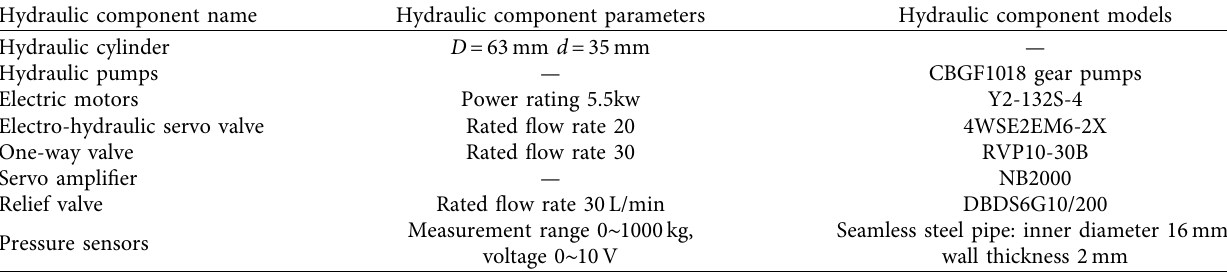
Table 1: Hydraulic control system component models of the test